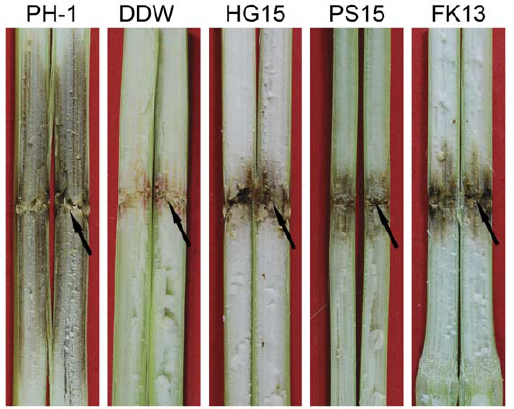
Figure 6. Corn stalks inoculated with the wild type (PH-1) and the Fghog1 (HG15), Fgpbs2 (PS15), and Fgssk2 (FK13) mutants were examined 10 dpi. Arrows pointed to the inoculation sites.